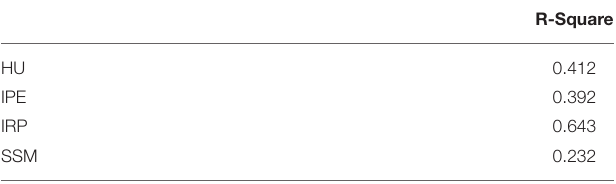
TABLE 4 | R-Square values for the